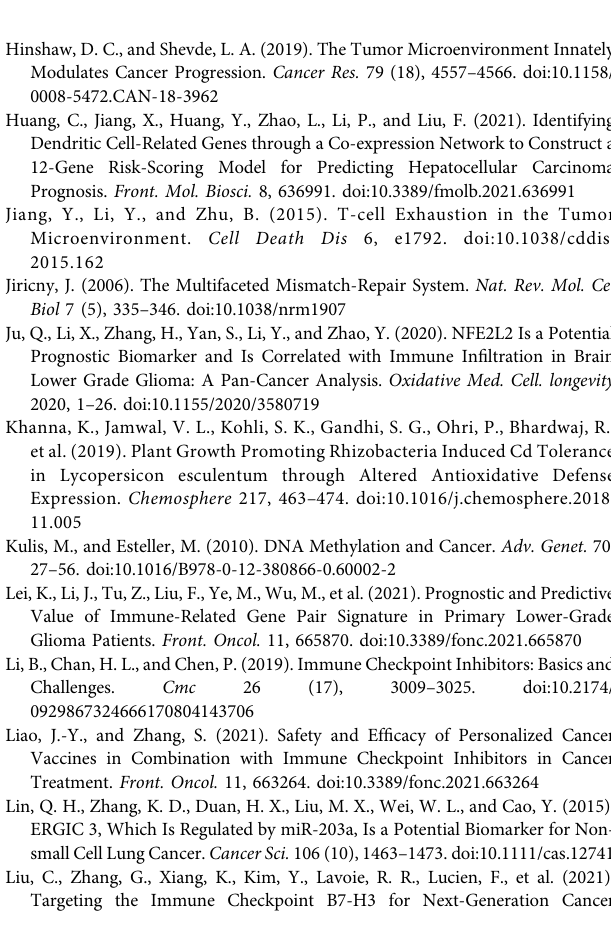
p < 0.001). (B) A positive correlation was found between OAS3 and four immune pathway-related genes (receptor, MHC, immunoinhibitors, and immunostimulators) in many tumour types. The lower upper triangle of each square represented the magnitude of the p value of the correlation test, and the upper triangle represented the correlation coef fi cient ( p p < 0.05, pp p < 0.01, ppp p < 0.001). Supplementary Figure 9 | The correlation between the sensitivity of drugs in the Genomic of Drug Sensitivity in Cancer (GDSC) database (A) , CTRP database (B) , and mRNA expression ofOAS3. ThePearson ’ s correlation indicates thecorrelation between gene expression and drugs sensitivity. Blue bubbles represented negative correlations, and red bubbles represented positive correlations; the deeper the color, the higher the correlation. The bubble size was positively correlated with the FDR signi fi cance. Supplementary Figure 10 | Pathway analysis. The abscissa represents the distribution of the gene expression, and the ordinate represents the distribution of the pathway score. The density curve on the right represents the trend in distribution of pathway immune score, the upper density curve represents the trend in distribution of the gene expression. The value on the top represents the correlation p value, correlation coef fi cient and correlation calculation